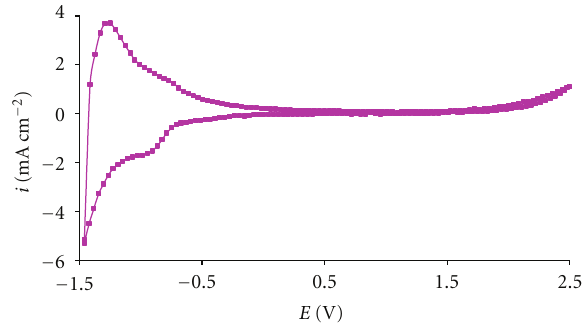
Figure 4: Example of cyclic voltammetry carried out at 0.1 M gly- cerol solution at TiO 2